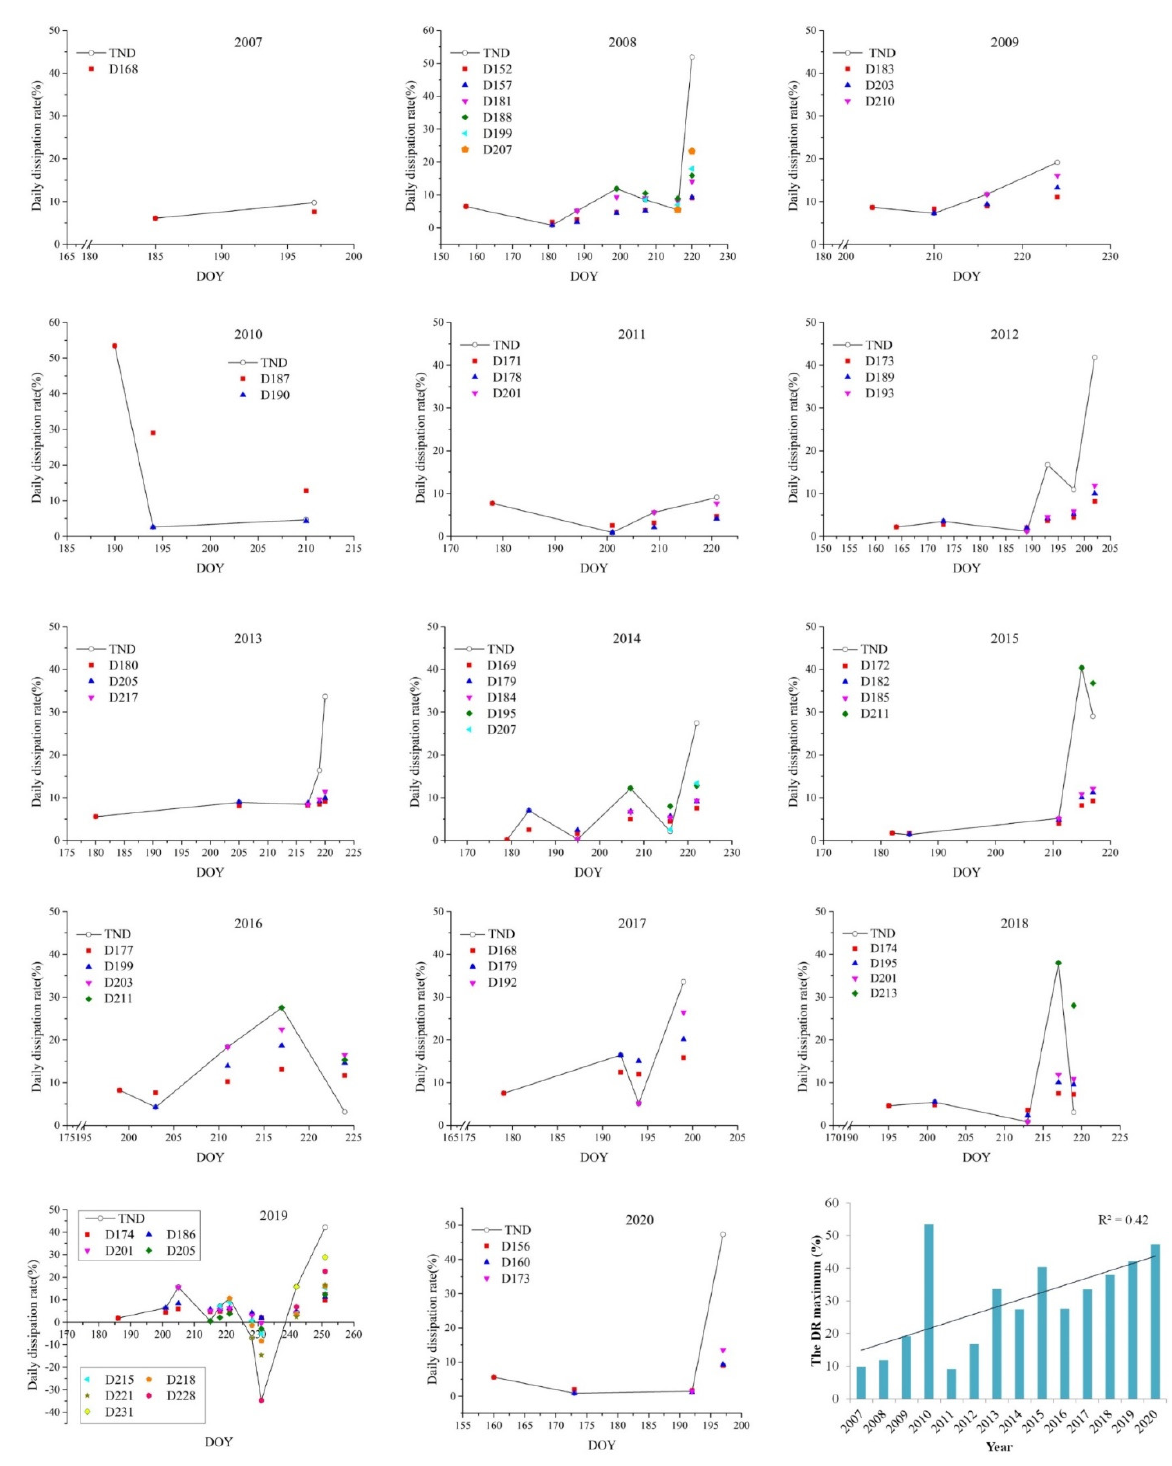
Figure 6. Daily dissipation rate (DR) from 2007 to 2020. DOY is day of year. Di represents DR from the same starting date (i) to different ending dates. e.g., ■ D168 in 2007 shows DR with the starting date of 168 (DOY), i.e., 17 June 2007, and ending date of 16 July 2007. TND is the DR in a period between every two neighboring dates and DSE is the DR calculated during the periods from the same starting date (i) to different ending